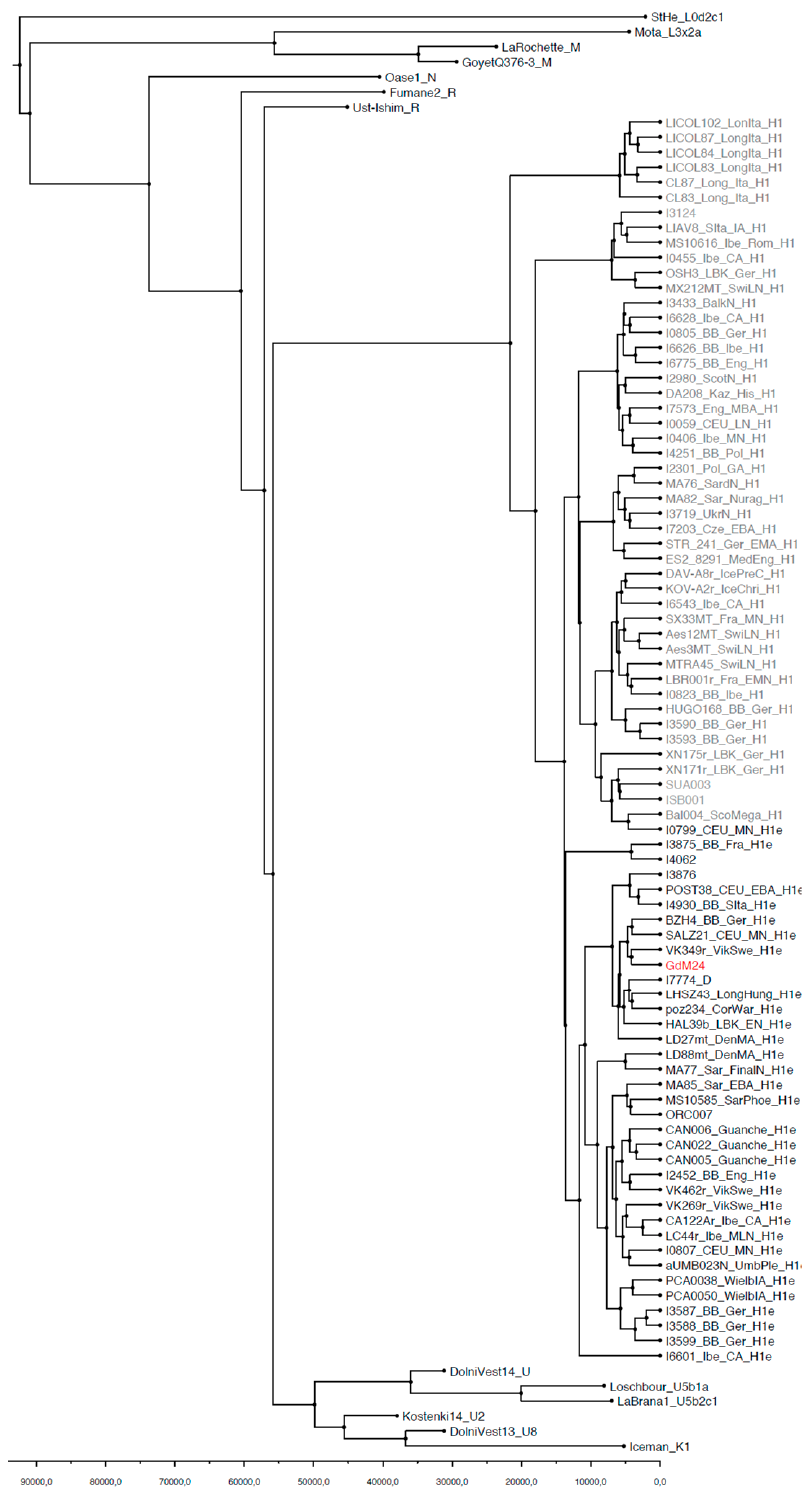
Figure 3. Phylogenetic tree reconstructed with BEAST using dated ancient reference samples as calibration points (Tables S4 and S5).